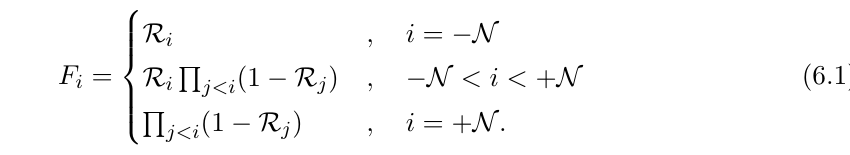
Figure 3 . Distributions of (left) ∆ E and (right) C 0 for (top) B + → D ( K 0 B + → D ( K 0 K − K + ) K + candidates restricted to the signal-enhanced region in the Belle data set S with fit projections overlaid. The black points with error bars represent data and the solid blue curve is the total fit. The large-dotted magenta, long-dashed red, small-dotted blue and short-dashed green curves represent B + → Dπ + , B + → DK + , q ¯ q and combinatorial B ¯ B background components, respectively. Differences between the fit function and data normalised by the uncertainty in data (pull) are shown under each